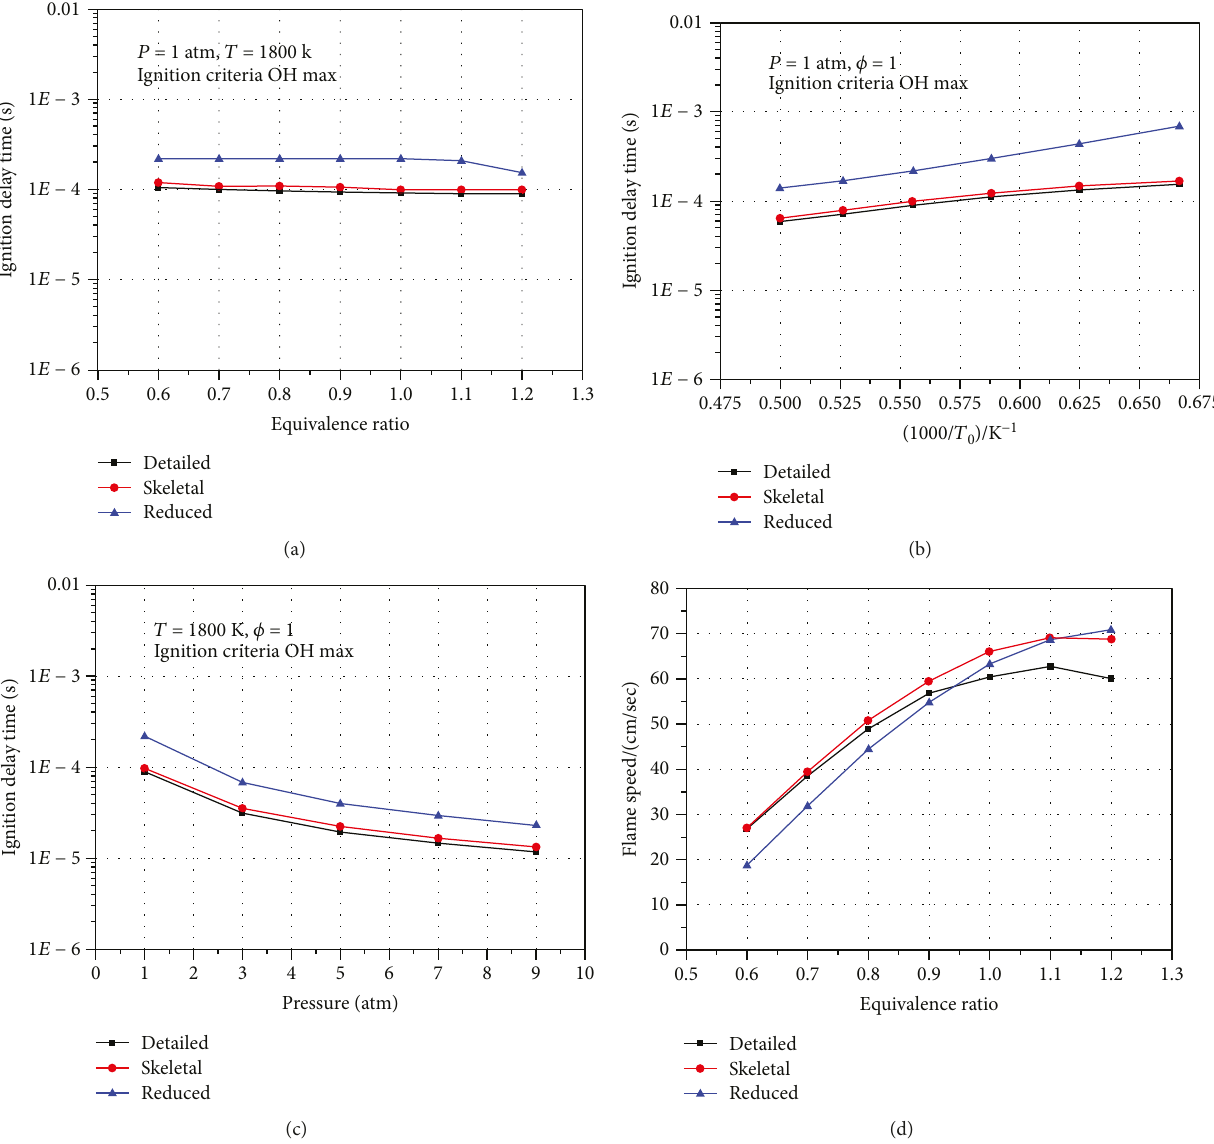
Figure 6: Simulation results for ignition delay time and fl ame propagation speed using reduced mechanism, skeletal mechanism, and detailed